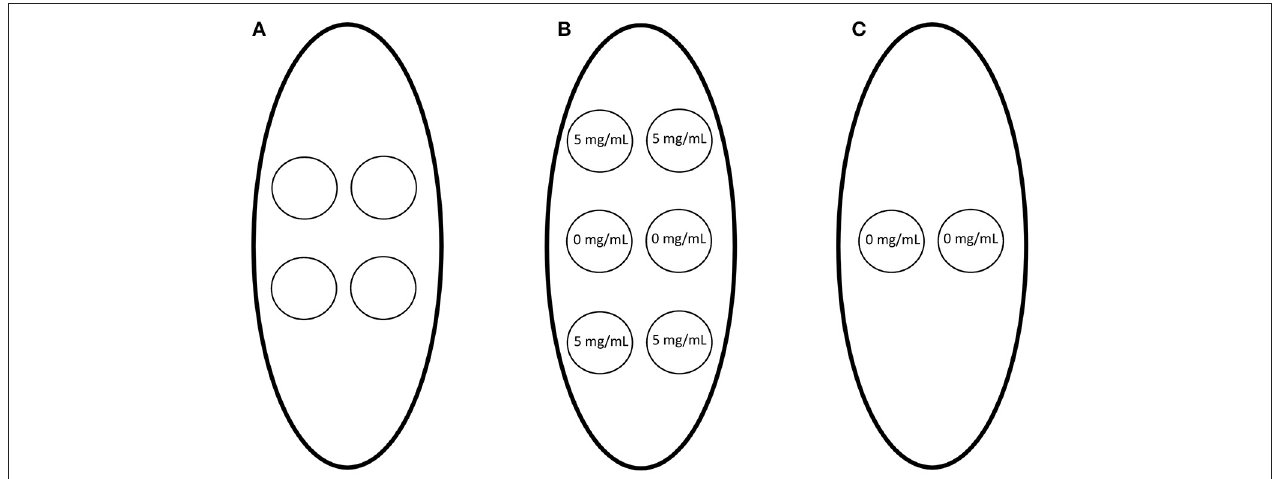
FIGURE 1 | Electrospun templates with 0–5 mg/mL Cl-Am were implanted subcutaneously on the dorsa of rats. (A) One template was implanted randomly per subcutaneous pocket. In addition, to determine if the drug-eluting materials had systemic effects due to diffusion or convection, (B) SD templates with 0 mg/mL Cl-Am were implanted between SD templates with 5 mg/mL Cl-Am and (C) SD templates with 0 mg/mL Cl-Am were implanted alone.